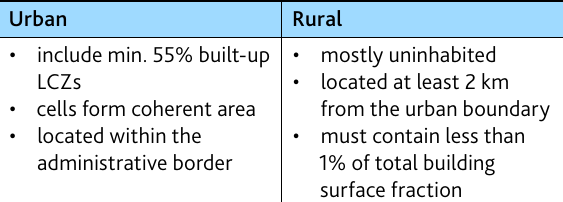
Table 1. Specification of urban and rural tiles